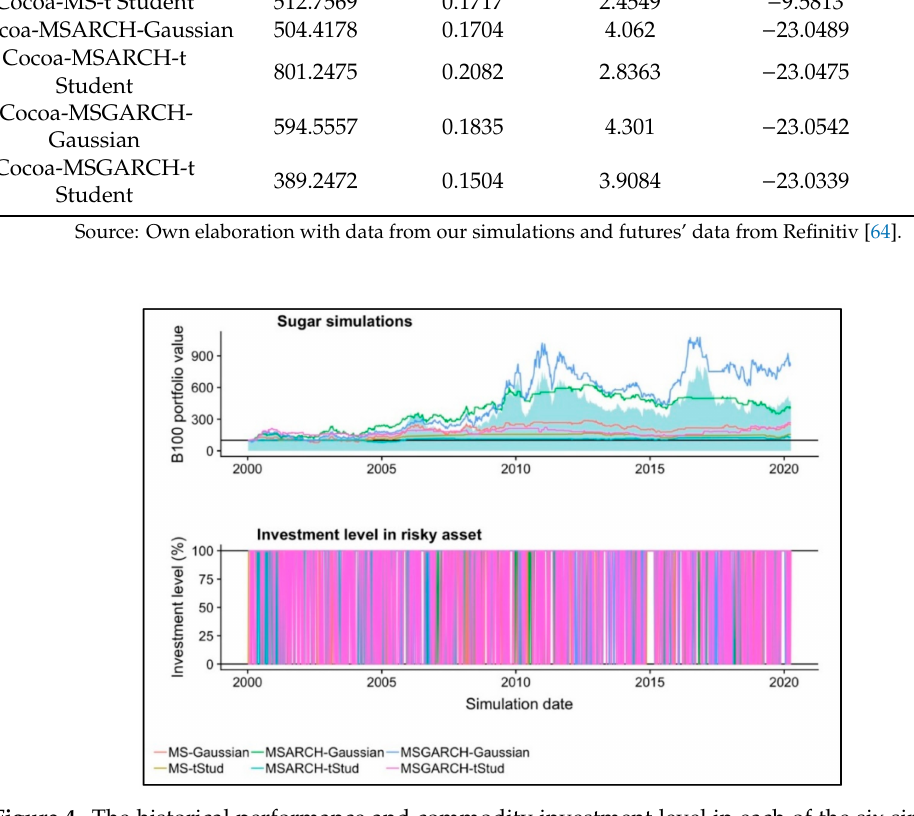
Figure 4. The historical performance and commodity investment level in each of the six simulated portfolios in the one-month sugar future